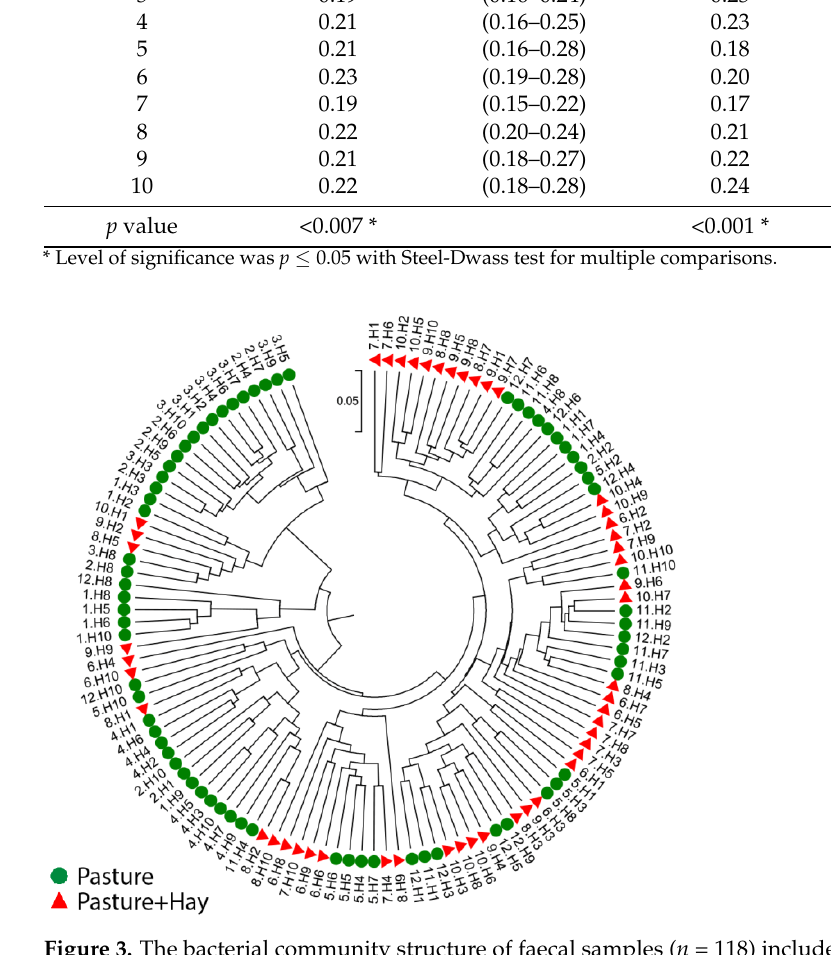
Figure 3. The bacterial community structure of faecal samples ( n = 118) included in the study. The circular cladogram showing beta diversity of the faecal sampleswas constructed using Unweighted Pair Group Method with Arithmetic Mean (UPGMA). The sample labels are coloured by diet periods and consist of a month number (1–12 representing January–December) and horse number (H1–H10).